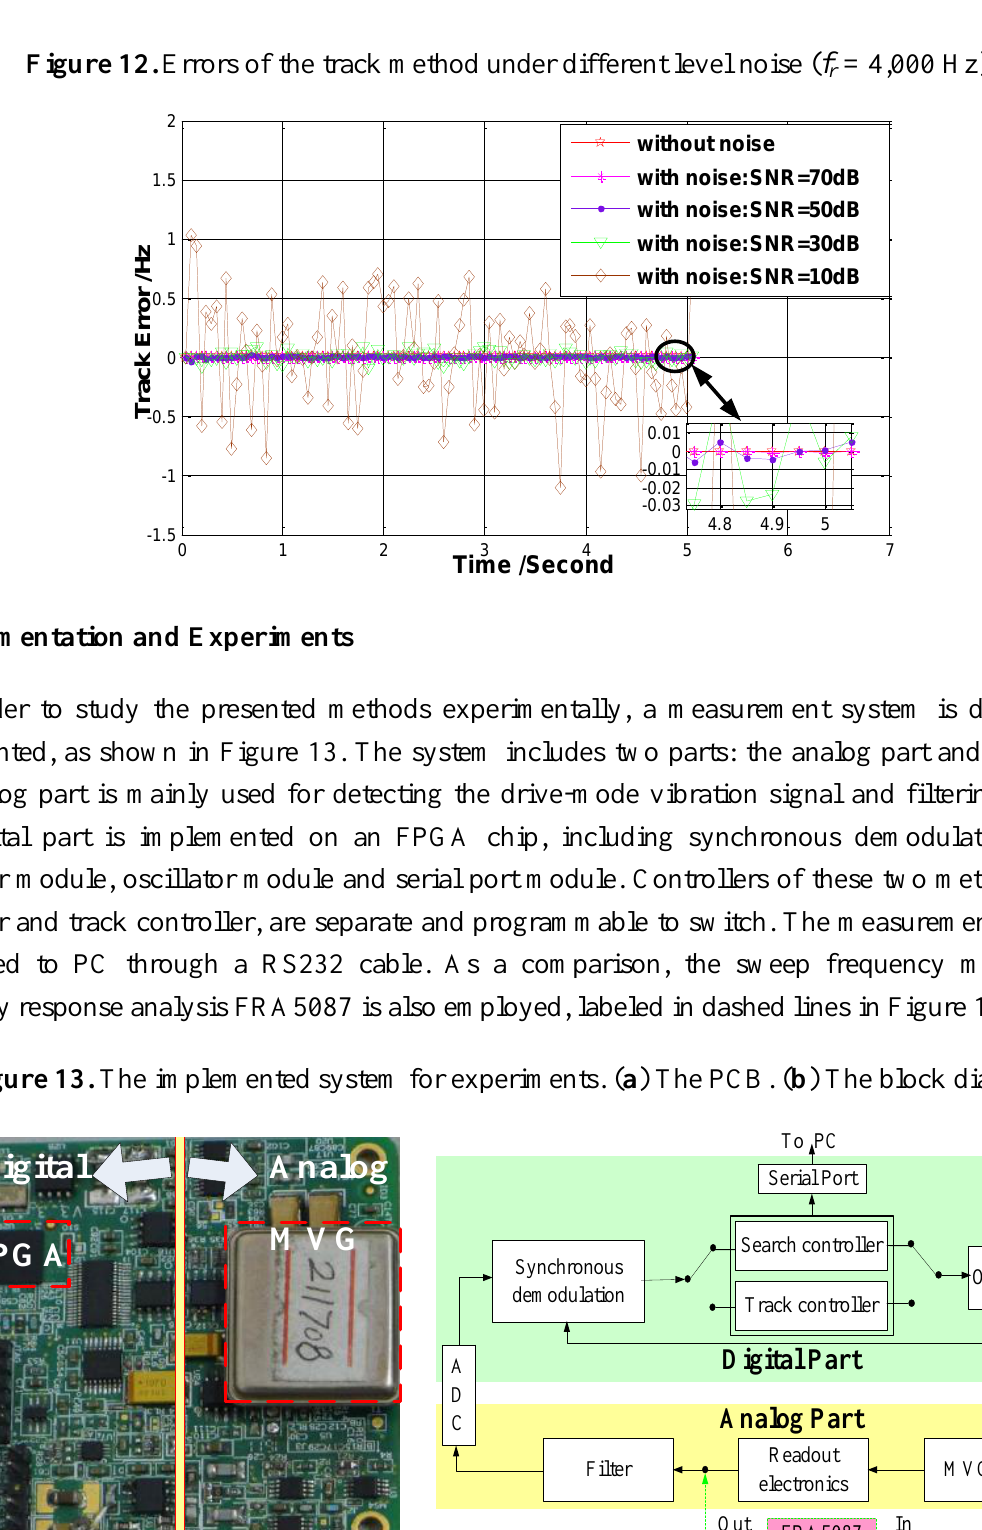
Figure 12. Errors of the track method under different level noise ( f